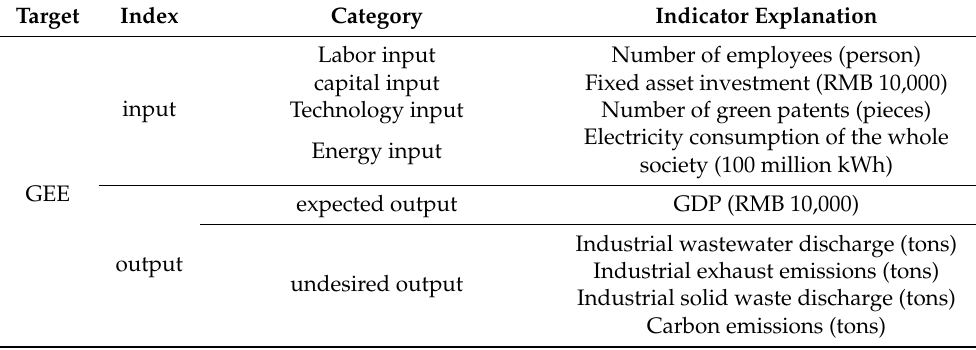
Table 1. GEE evaluation index